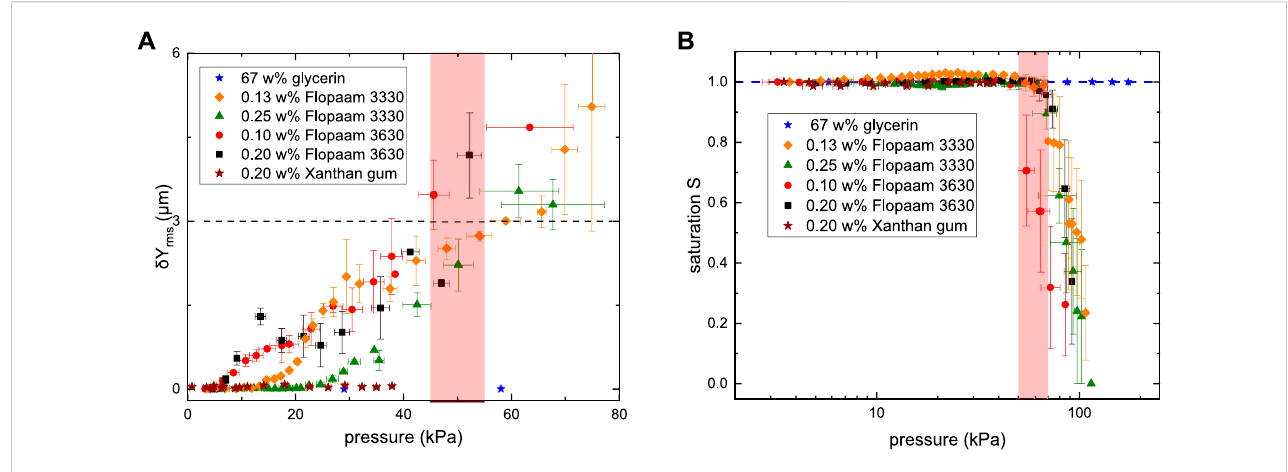
FIGURE 8 (B) remainingoilsaturation S asfunctionsofthemeasuredpressuredifference (cid:2) P (A) The fl uctuationintensity δ Y rms and (A) indicates δ Y ≈ 3 μ m, where we observe the onset of displacement in Figure 7B. The red areas in (A) and (B) refer to the pressure ranges associated with rms the onset of displacement. The symbols in (A) and (B) represent experimental data for 67 w% glycerin (blue star), 0.13 w% Flopaam 3330 (orange